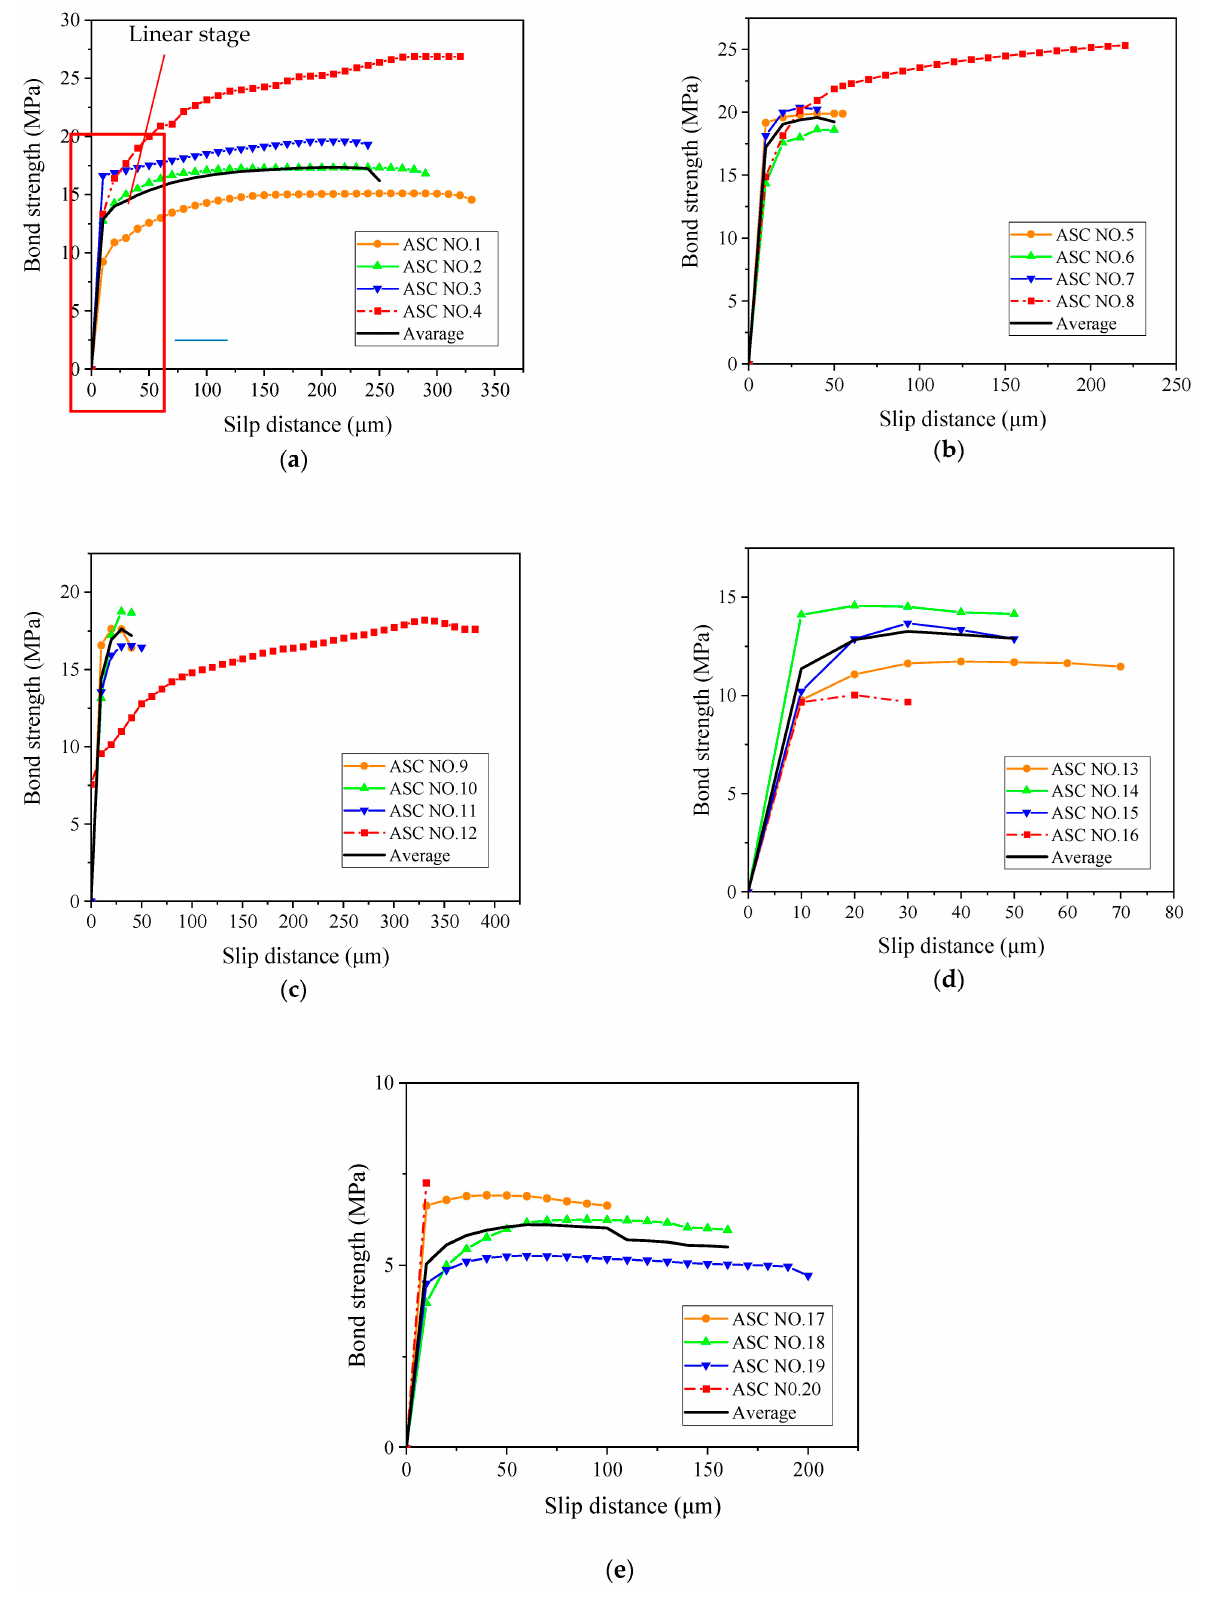
Figure 10. ASC bond–slip curve (actual corrosion degree): ( a ) control; ( b ) 0.4%; ( c ) 0.83%; ( d ) 1.53%; and ( e ) 2.57% .